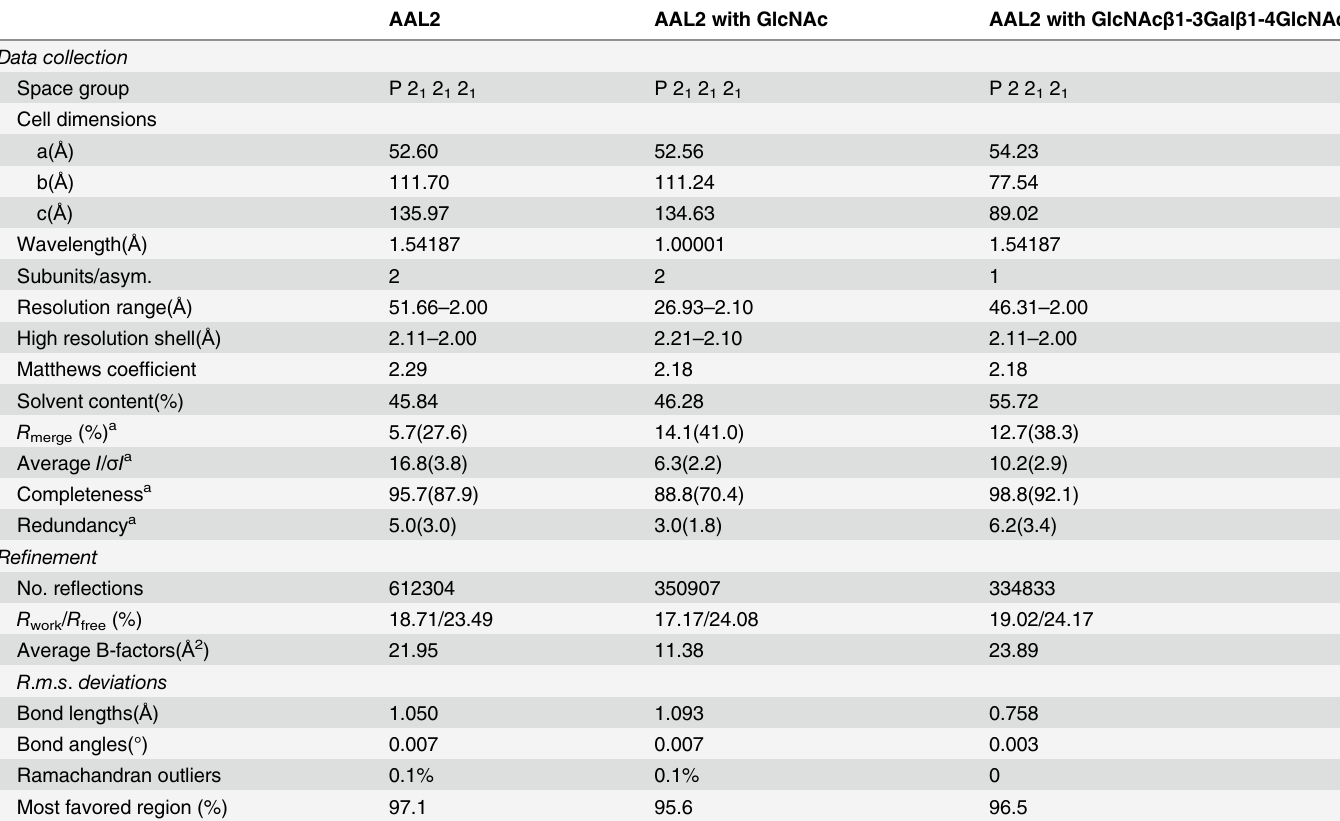
Table 1. Data collection, processing and structural refinement statistics for AAL2, AAL2 complex with GlcNAc and AAL2 complex with GlcNAc β 1- 3Gal β